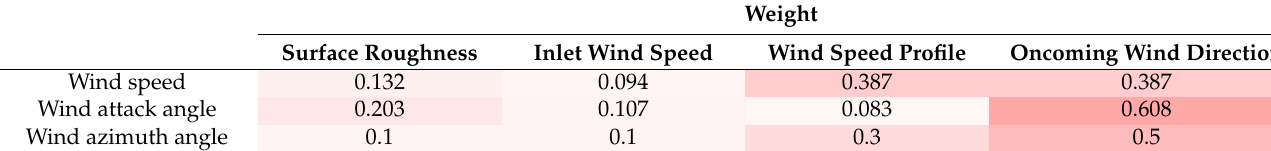
Table 6. Weight matrix of